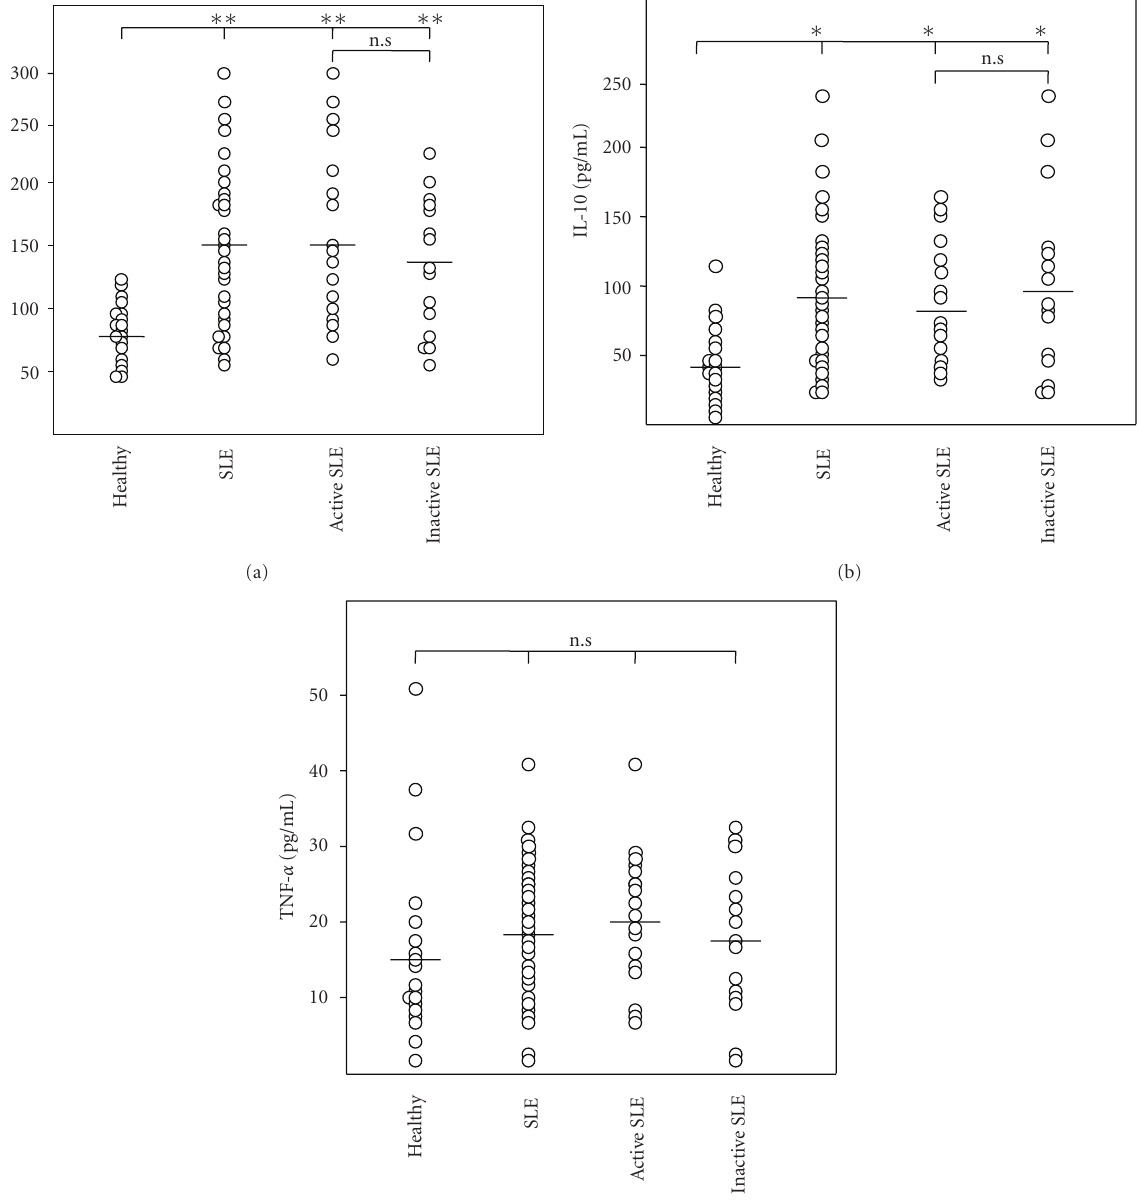
GM1 on peripheral blood CD4+ and CD8+ T cells, respec- tively, and found that CD4+ T cells expressed elevated GM1, but CD8+ T cells did not, in SLE patients. In addition, GM1 expressions on memory T cells (CD45RO/CD4) and CD4+ T cells were dramaticly increased after PHA stimulation in vitro . Furthermore, number of GM1-highly expressing CD45RO+CD4+ memory T cells were significantly increased in SLE patients compared with healthy controls (Figure 2(e)). These data may indicate that cellular membrane adopts an increased lipid raft structure upon mitogenic stimulation